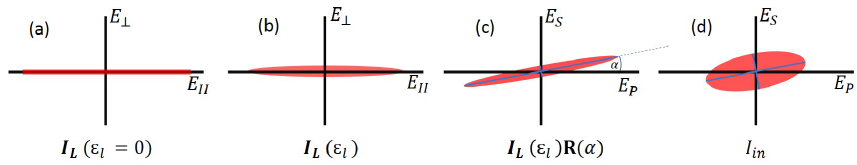
Figure 3. (a) Polarization state of the light generated by the laser (100% linearly polarized); E denotes electromagnetic field. (b) The laser radiation is elliptically polarized after passing the beam expander (see Fig. 1). (c) The receiving cross- and co-polarized signal channels ( E S and E P ) are usually not perfectly aligned to the main polarization plane of the laser radiation, i.e., α > 0. (d) Polarization plane in the receiver for light which has been backscattered and depolarized by the